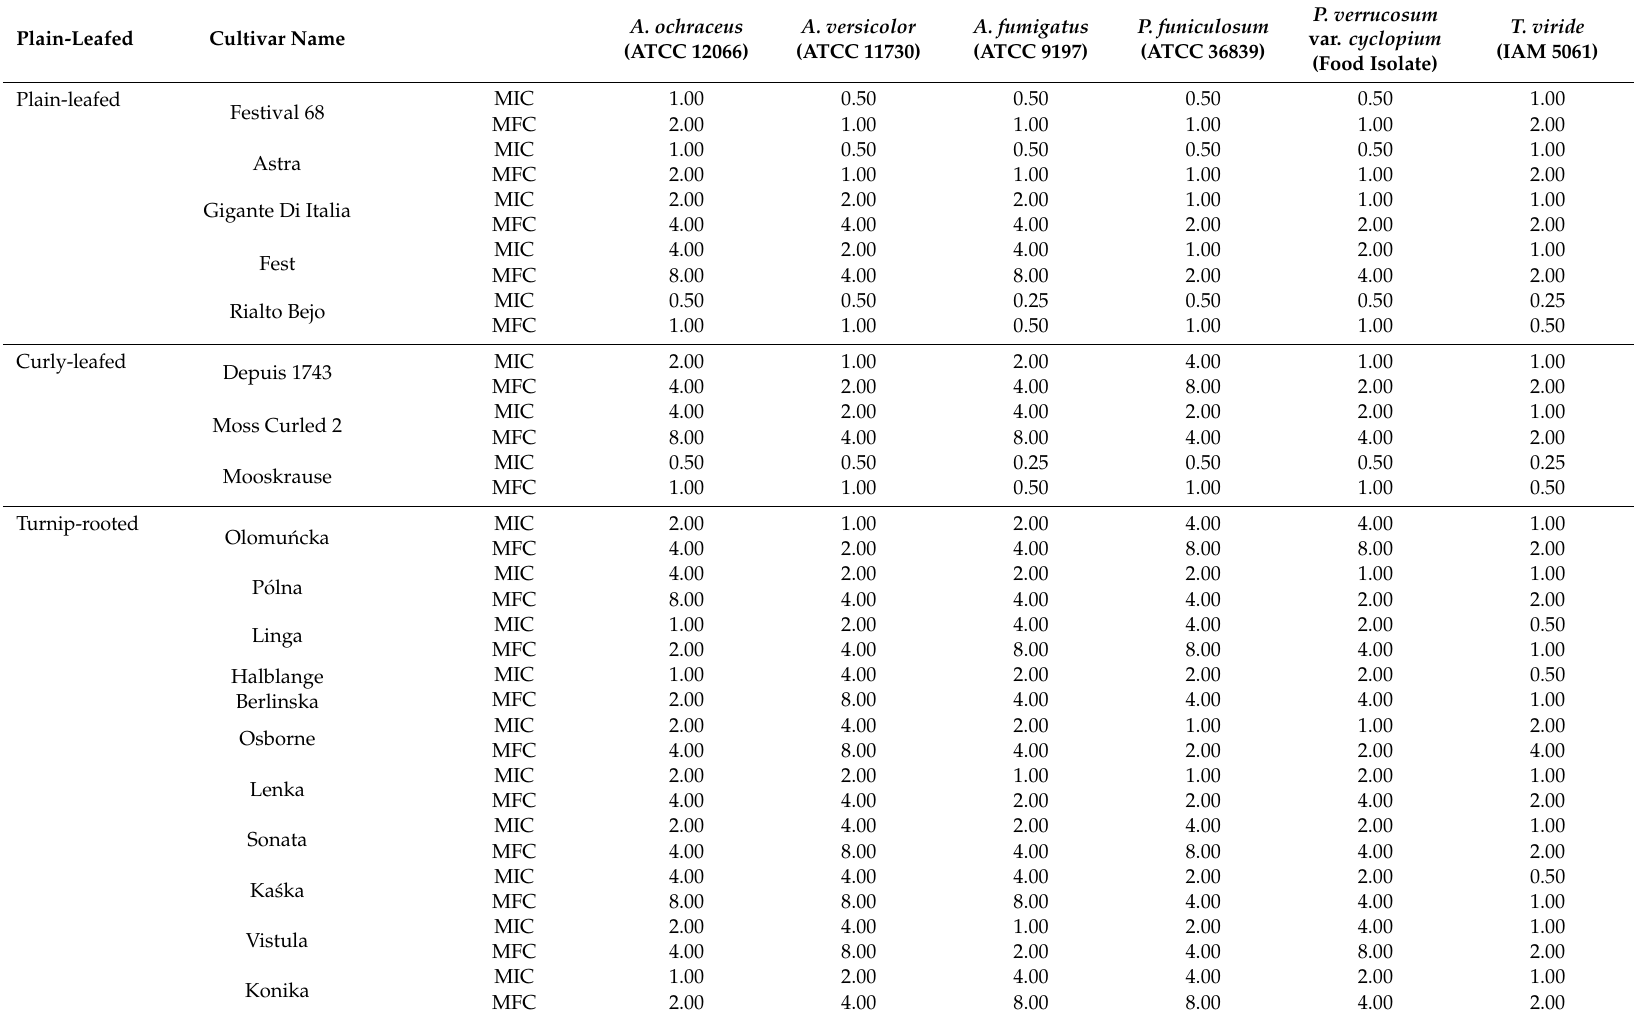
Table 5. Antifungal activity of parsley leaves’ hydroethanolic extracts (MIC and minimal fungicidal concentration (MFC) mg / mL).